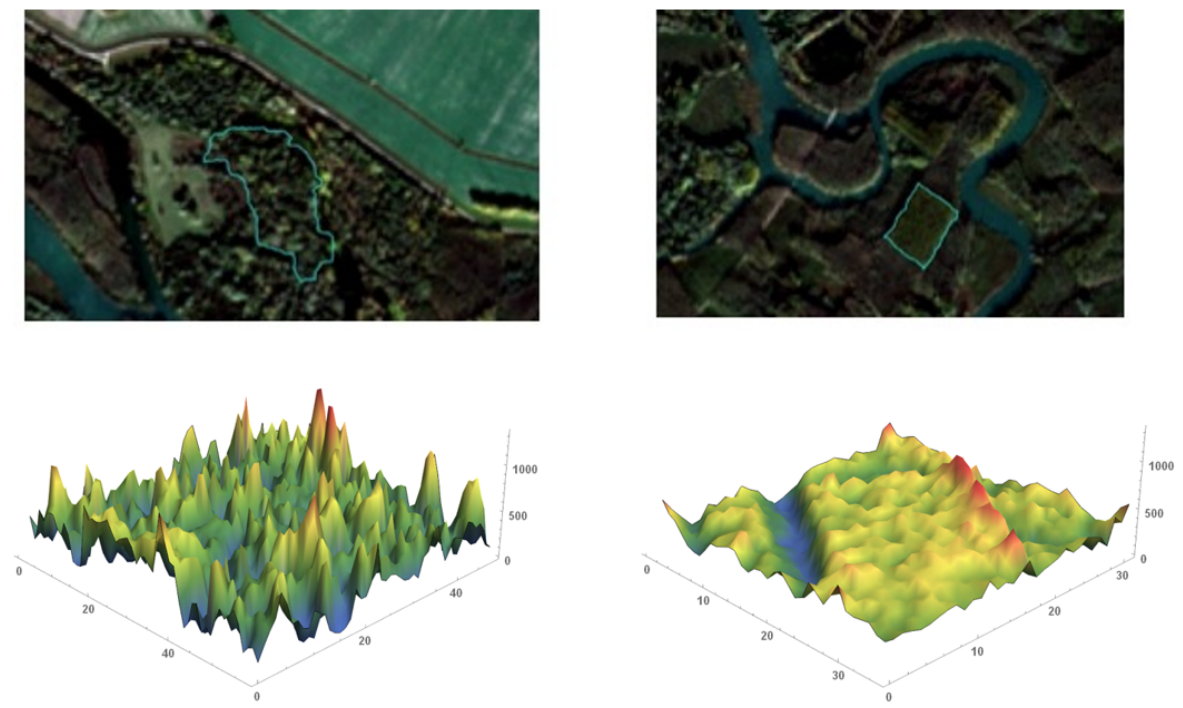
Figure 8. Variability of the image intensity values inside natural forest area is high ( left ), which is expressed in high values of RHL, while in the plantation, ( right ) the image intensity is smoother, which is expressed in low values of RHL.